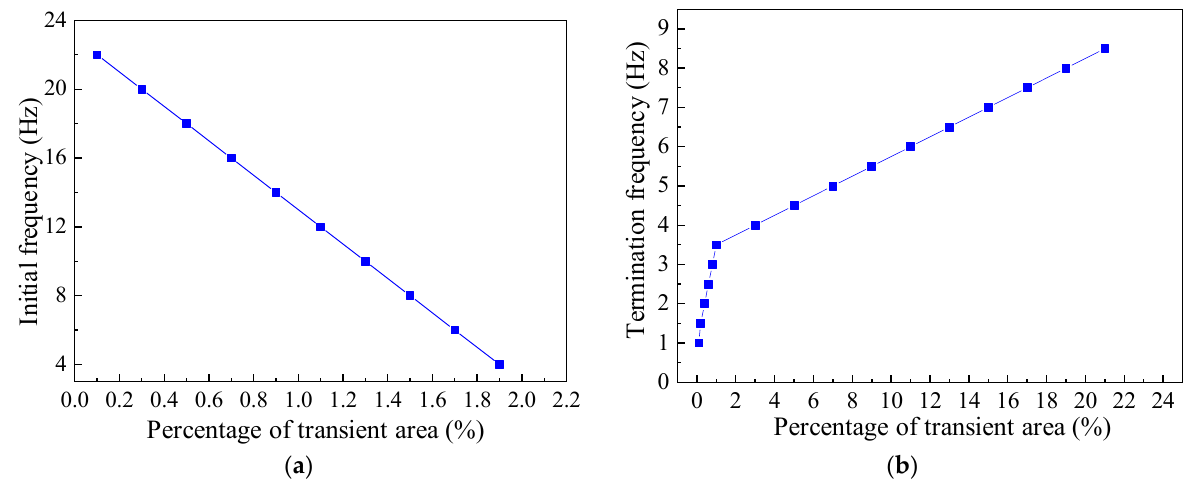
Figure 11. The relationship between initial frequency, termination frequency and fracture quality: ( a ) Relationship between f 0 and fracture quality; ( b ) Relationship between f 1 and fracture quality.